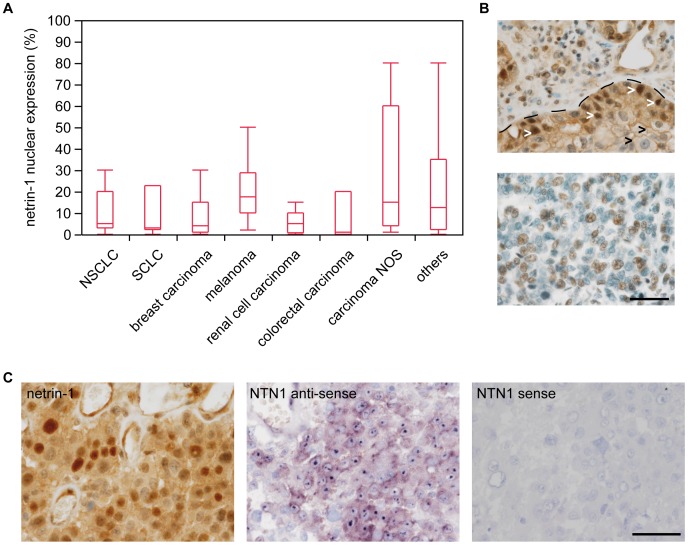
Nuclear localization of netrin-1 in brain metastases.(A) Box plots showing different expression profiles of nuclear netrin-1 in brain metastases of the tumor types indicated (see also Table S1). (B, upper) Example of NSCLC with strong cytoplasmic and nuclear netrin-1 expression. Dotted line shows tumor to mesenchymal stroma border with a regionally heterogenous netrin-1 expression pattern. While tumor cells adjacent to the stroma show strong nuclear staining, tumor cells inside the tumor nodule exhibit weaker netrin-1 expression without showing a nuclear localization. (B, lower) Brain metastases of breast carcinoma exclusively showing nuclear netrin-1 expression (scale bar 50 μm). (C) Comparison of netrin-1 protein expression and mRNA levels in an exemplaric case of melanoma brain metastasis (scale bar 50 μm). While netrin-1 protein can be detected in cytoplasms but stronger in nuclei, in-situ hybridization reveals a mild cytoplasmic staining compared to stronger signals within the nucleus.